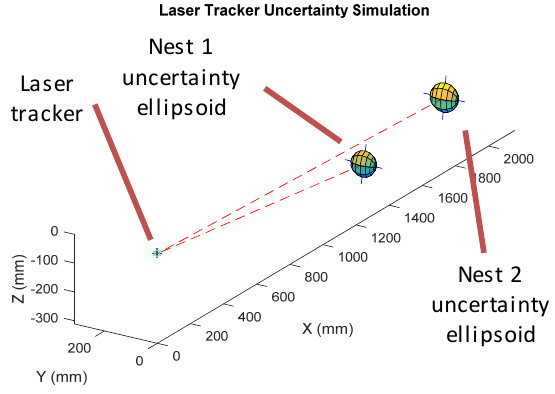
Figure 14. Laser tracker uncertainty simulation of ballbar calibration length.